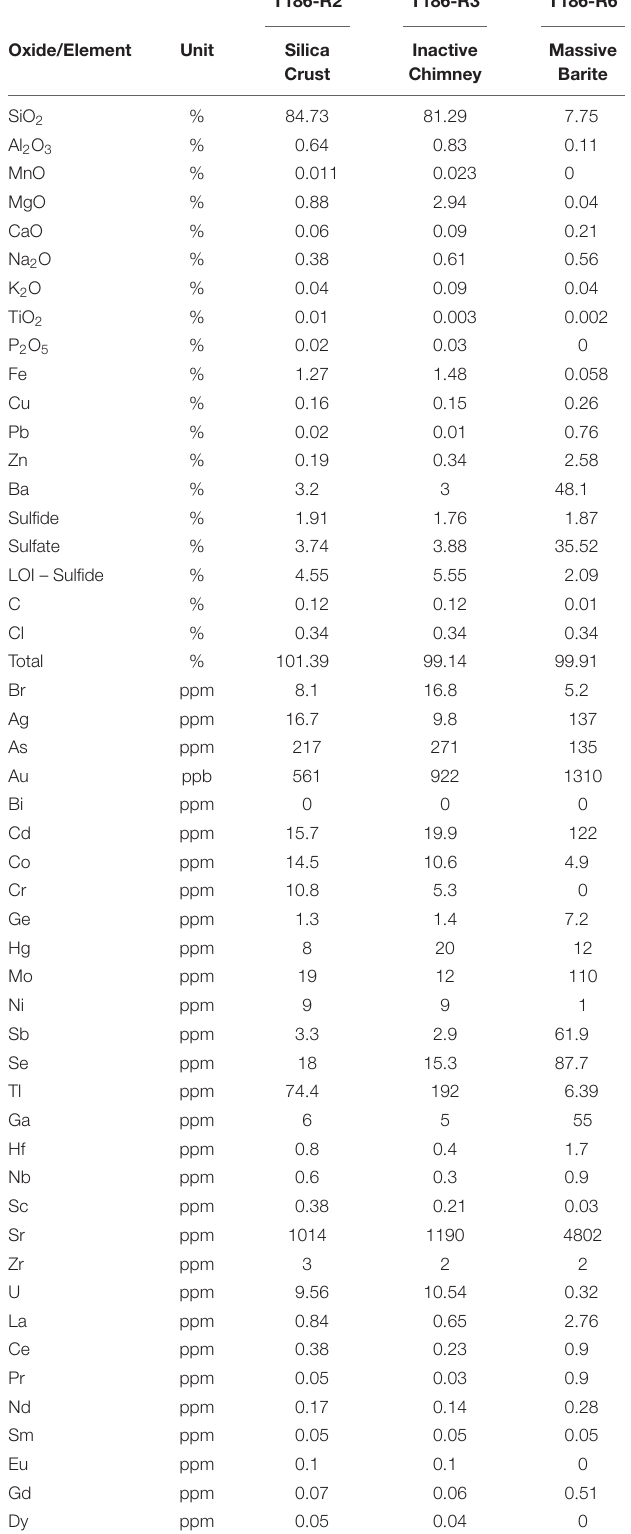
TABLE 1 | Composition of hydrothermal samples from sea cliff vent field. T186-R2 T186-R3 T186-R6